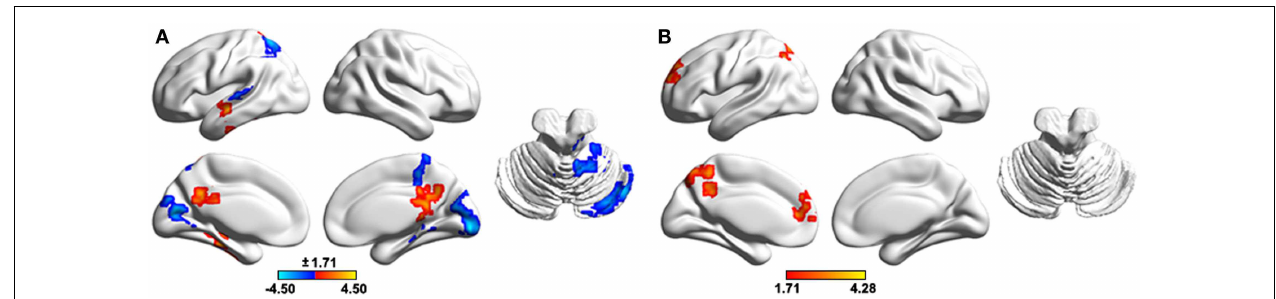
with weighted degree centrality as the dependent variable, group status (0 or 1) and voxel-specific gray matter volume as independent variables, and gender, age, and head motion as unconcerned covariates.The results were mapped into the brain surface using the BrainNet viewer